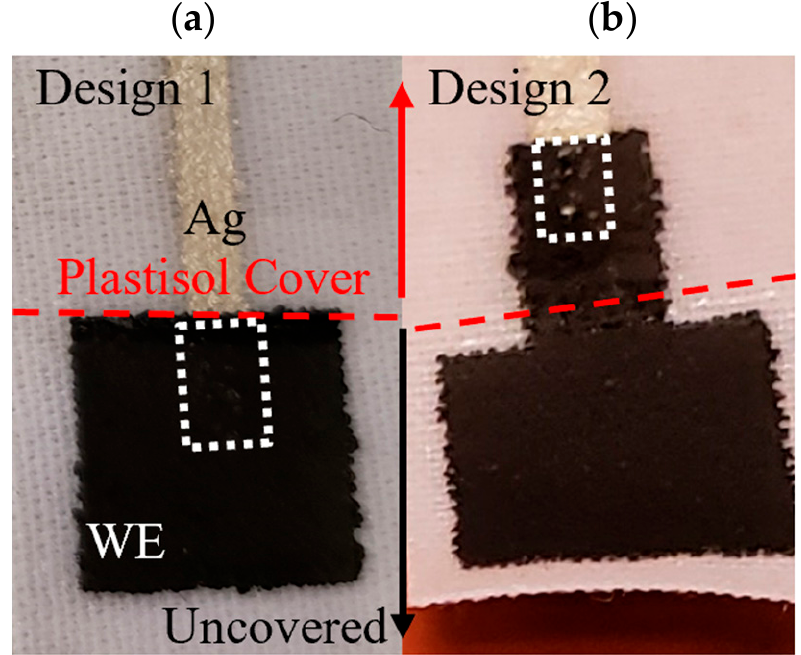
Figure 4. ( a ) Design 1 and ( b ) Design 2, considered for the connection between the electrode and the conductive trace of the textile SPEs. The red dashed line indicates how far the plastisol cover extend down; the white trace indicates how far the Ag trace extends under the WE.